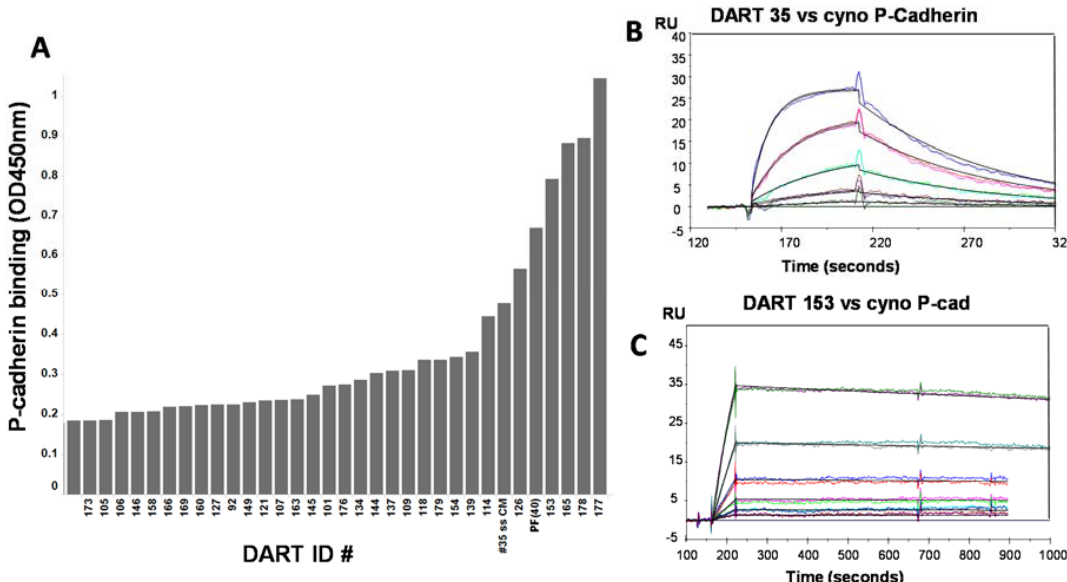
Figure 3. ( A ) Direct P ‐ cadherin binding ELISA data (OD450 nm) of conditioned media samples of affinity matured DARTs compared to parental DART 35 and prototype (PF) DART. Surface plasmon resonance (SPR) Biacore sensogram shows ( B ) DART 35 and ( C ) DART 153 binding to cynomolgus P ‐ cadherin extracellular domain (ECD) immobilized on the surface. Colored lines represent the fit to